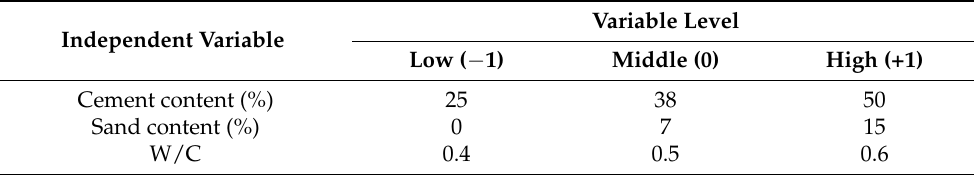
Table 5. Experimental coding level.